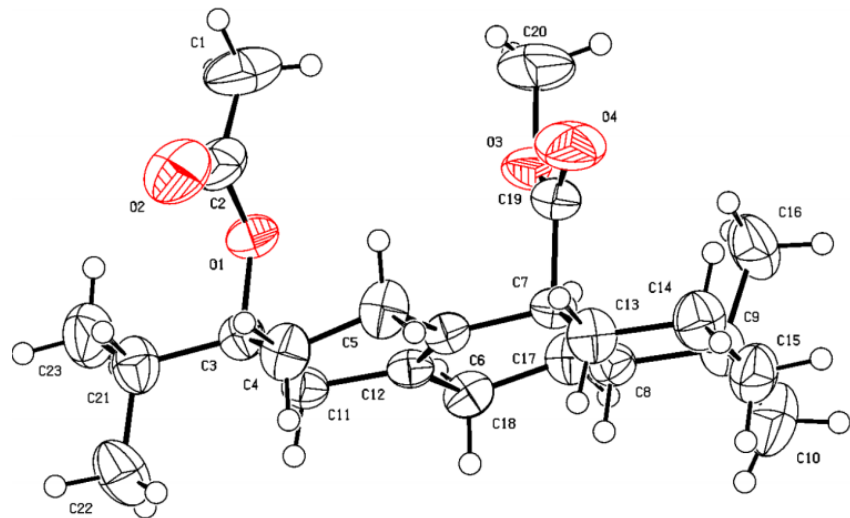
Figure 2. The 1 H NMR spectra of 3a ( a ), 6a ( b ), and 6c ( c ).